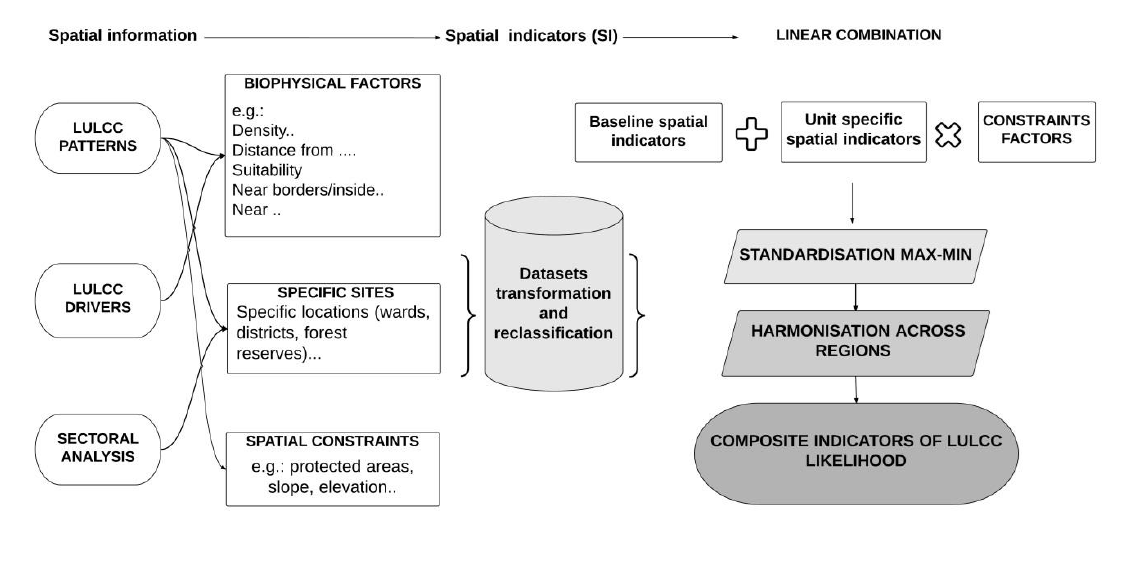
Fig.A2.1: Schematic model for building composite indicators of change likelihood from spatial information collected during multi-stakeholders